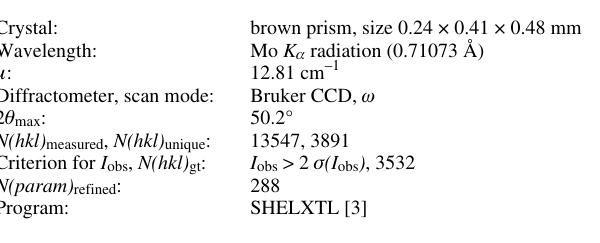
Table 1. Data collection and handling.